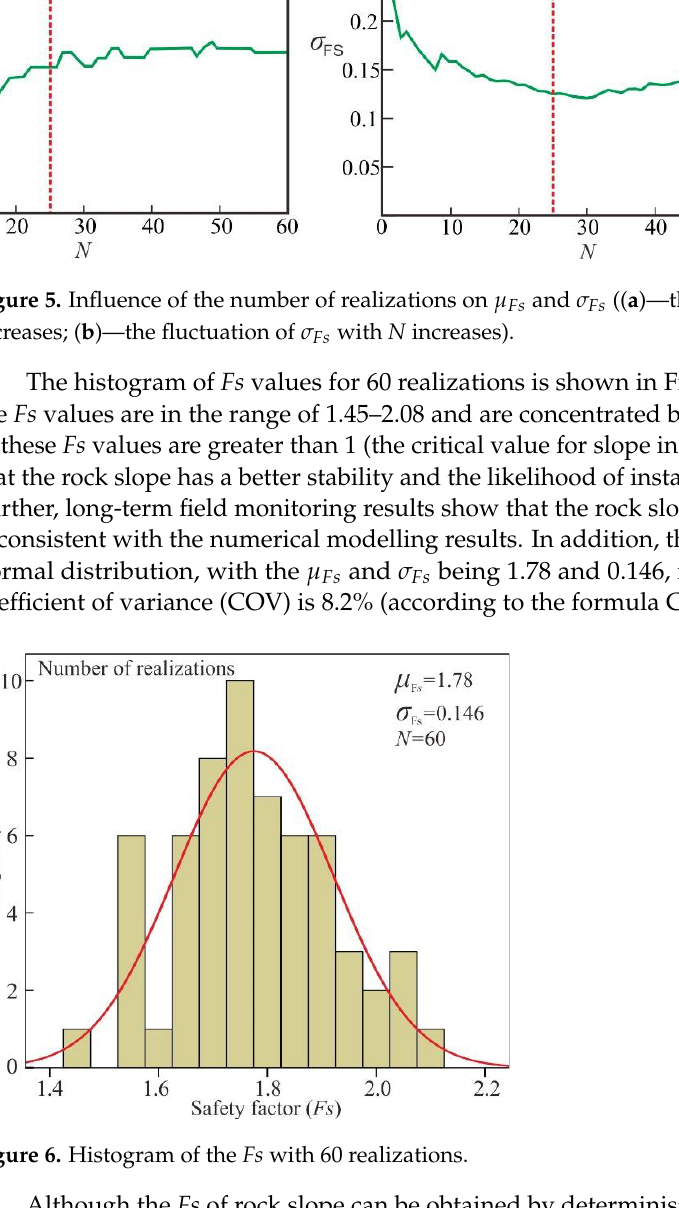
Figure 6. Histogram of the Fs with 60 realizations.